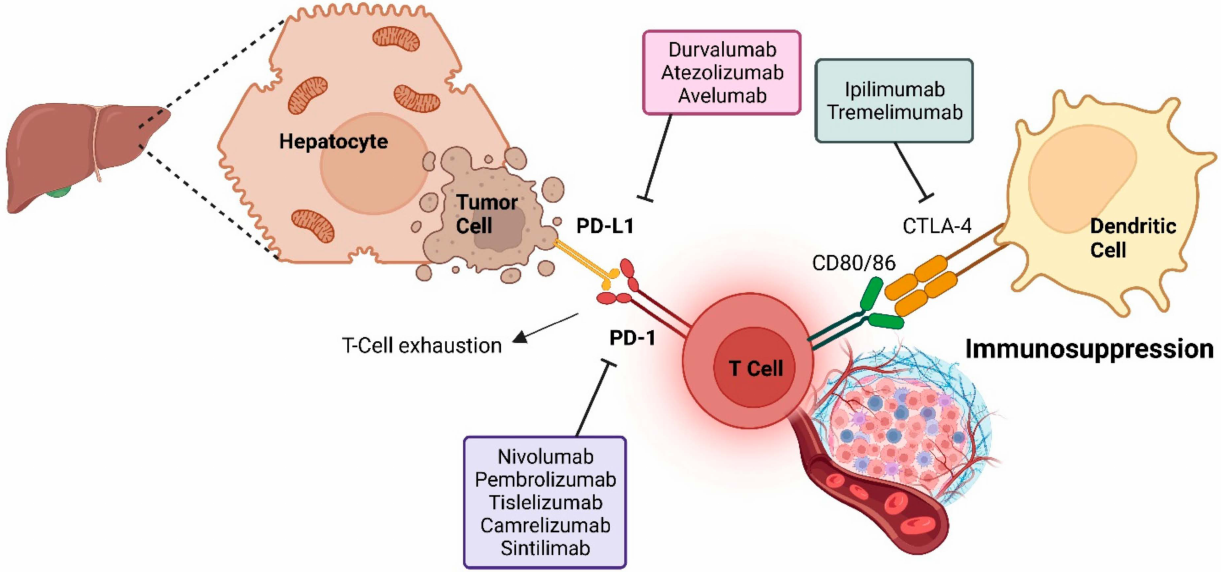
Figure 3. Immune checkpoint inhibitors mechanism of action against HCC tumor